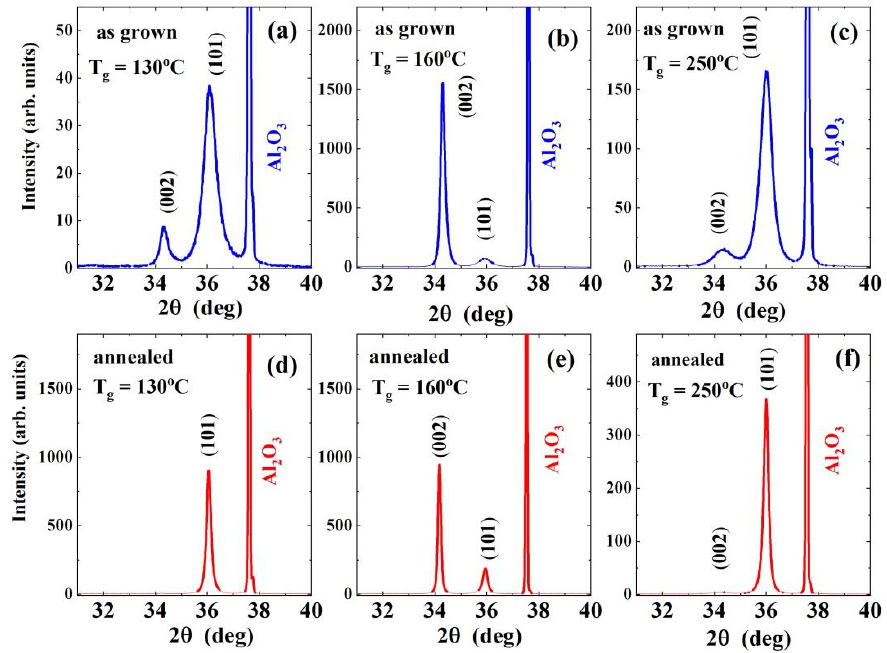
Figure 2. X-ray diffractograms of as grown ( a – c ) and annealed ( d – f ) ZnO/a-Al 2 O 3 films grown at 100 °C, 160 °C, and 250 °C.